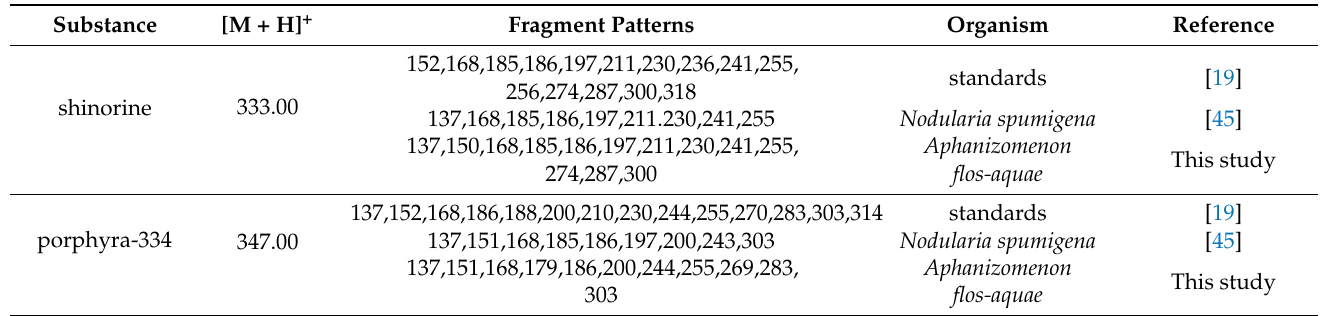
Table 2. Fragments of shinorine and porphyra-334 in different organisms.